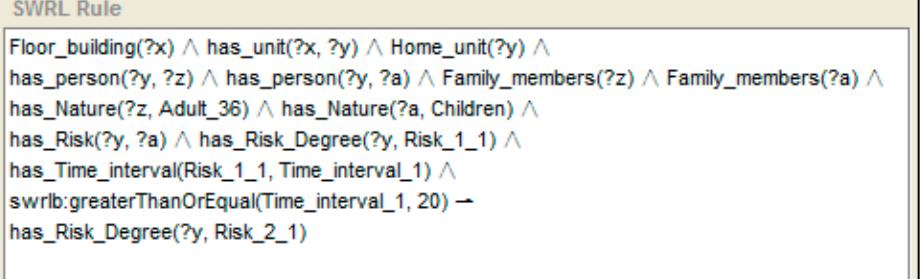
Figure 13. An example of reasoning for the upgrade of the degree of risk.